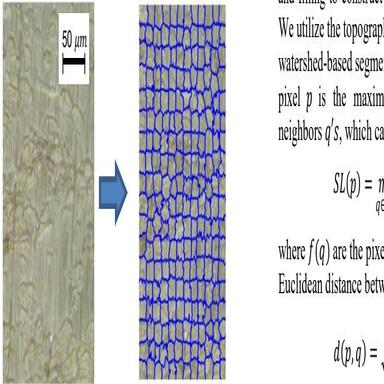
uper-pixels generated by the SLIC method (blue lines denote edges of super-pixels) in an original image